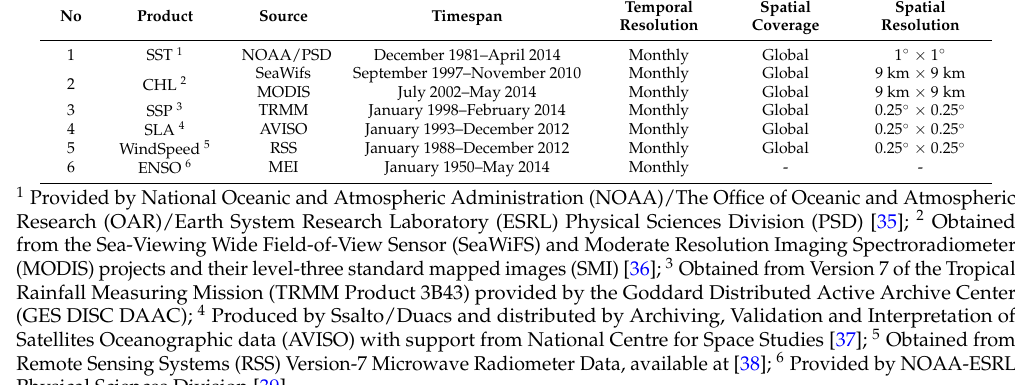
Table 1. Sources and resolutions of remote sensing products and multivariate ENSO index (MEI) used in this manuscript.